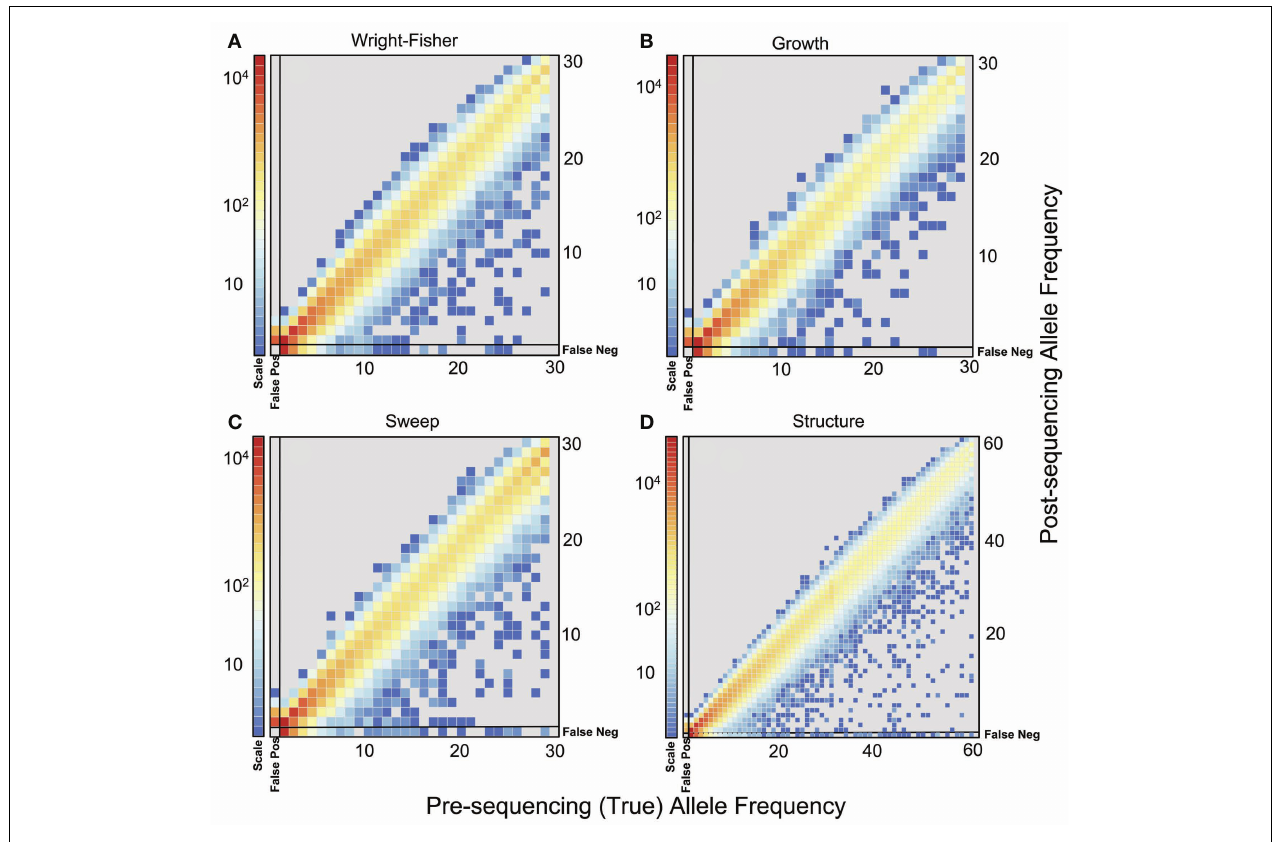
most column of each plot.The frequencies of true SNPs that were missed after sequencing (false negatives) are plotted in the bottom row of each plot. For the population structure model, frequency was calculated as average frequency across both subpopulations. Colors indicate the total number of SNPs (on a log scale) in each bin from 100 simulations for each